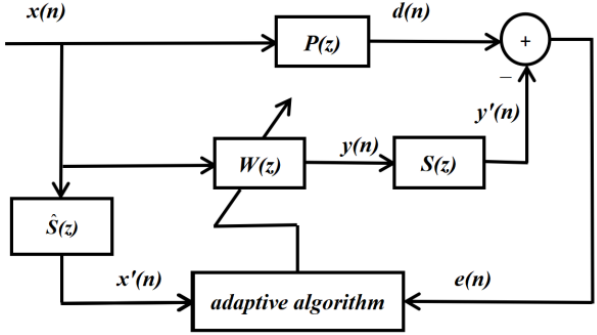
Figure 1. Schematic diagram of the feed-forward active noise control system.